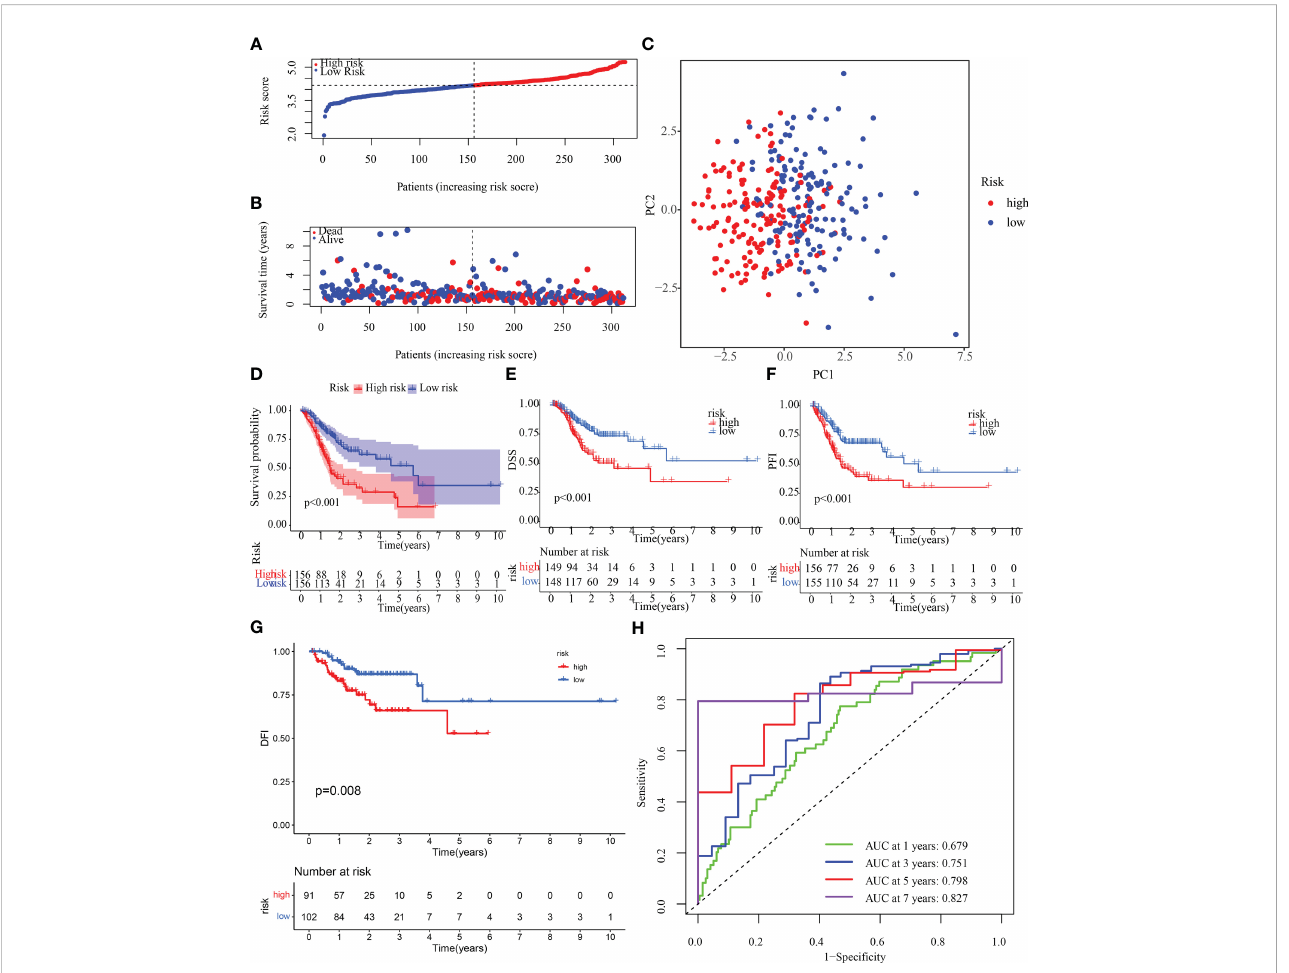
FIGURE 7 Construction of OMRG-related signature in the training cohort. (A) Various groups of the training cohort were created premised on the median risk score. (B) The survival rate of the training cohort as well as the distributions of risk scores (C) PCA for the training cohort. (D-G) KM analyses (OS, DSS, DFI, and PFI) of the training cohort. (H) Values of the AUC for the training